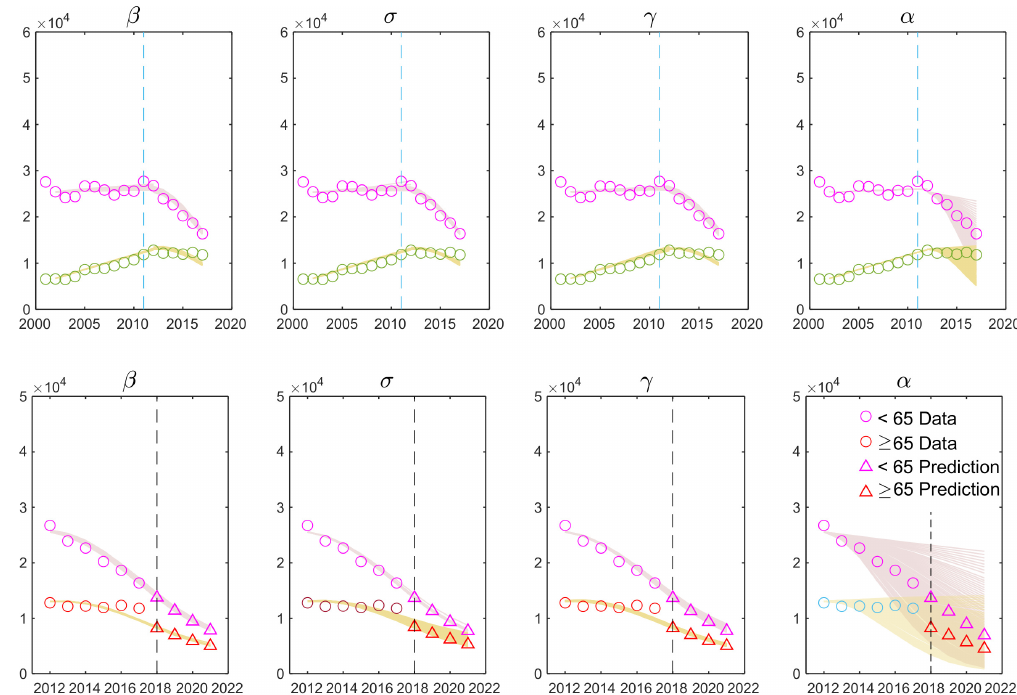
Figure 7. The top panel shows the impacts of the 4 estimated parameter values given in Table 6. Note that the impact of the transmission rate ( β ) and the early detection effort ( α ) was significant in both Groups 1 and 2. The bottom panel shows short-term predictions for 2019–2022 under the same parameter values estimated for the period 2012–2018. Note that maintaining various policies will decrease TB incidence in both